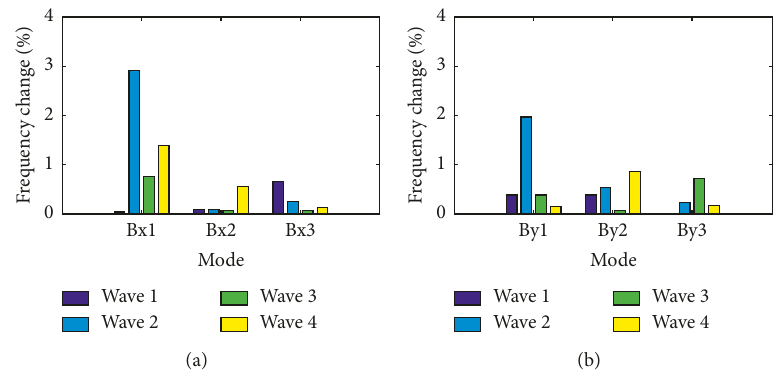
Figure 20: Variation of natural frequencies of Waves 1–4 relative to eigenvalue analysis. (a) Along-wave bending mode. (b) Across-wave bending mode.